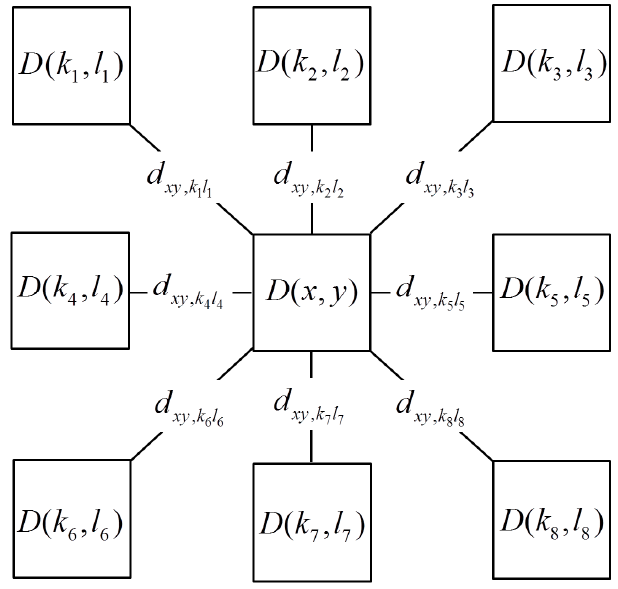
Figure 5. Node and neighbor nodes.